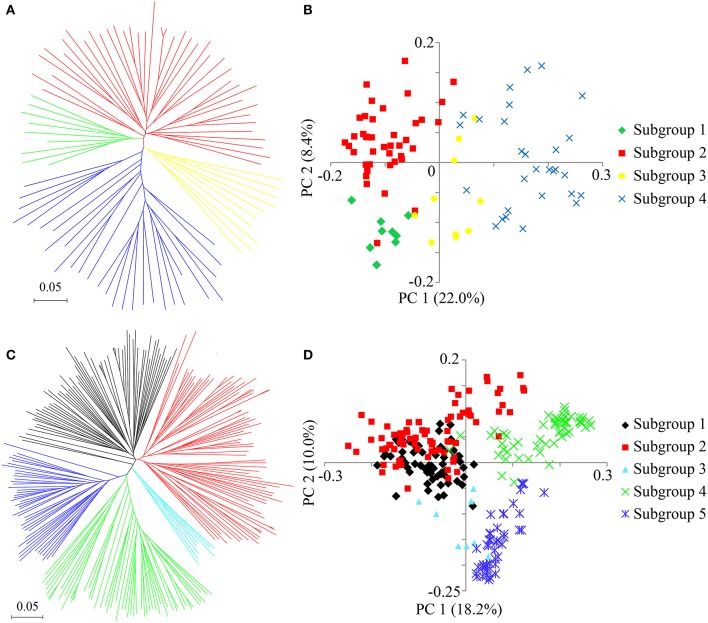
Population structure of the improved lines and landraces. (A) Neighbor-joining tree of 89 improved lines. (B) PCA plot of the first two components of the 89 improved lines. (C) Neighbor-joining tree of 266 landraces. (D) PCA plot of the first two components of the 266 landraces. The subgroups identified from the neighbor-joining tree are color-coded in each corresponding PCA plot.